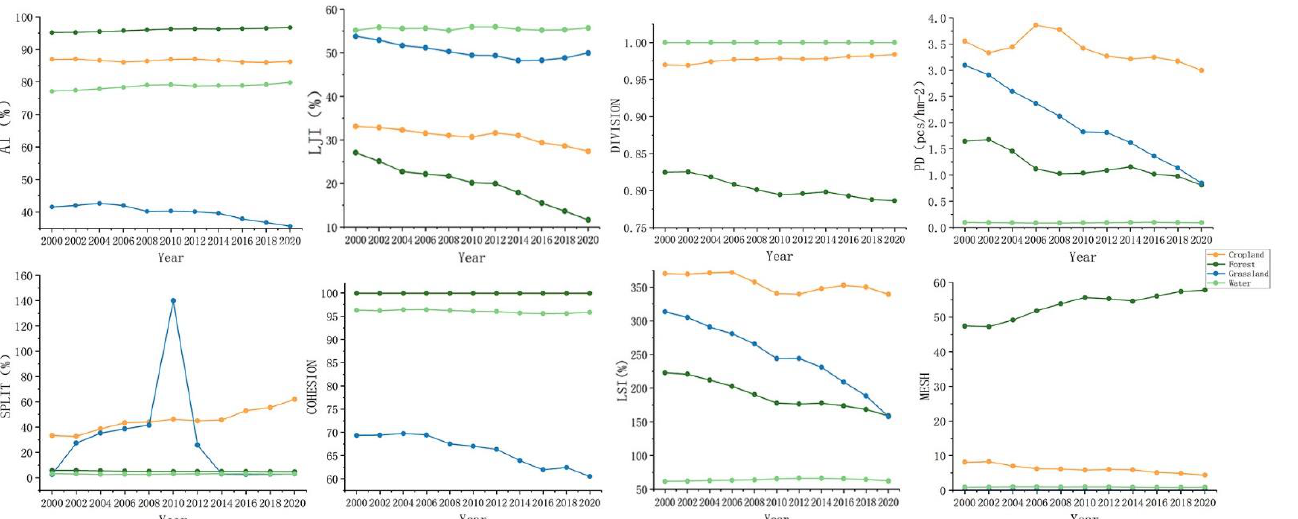
Table 5. Landscape-level index.